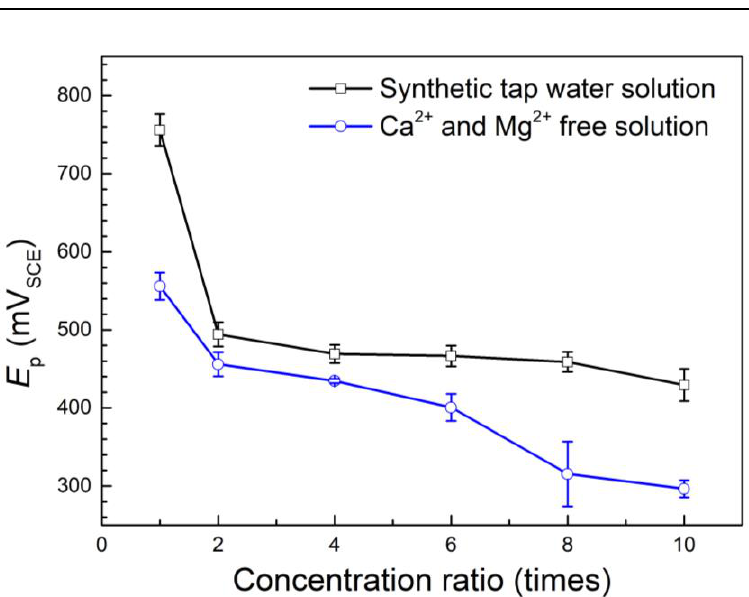
Figure 12. Pitting potentials of specimens in the two solutions with different concentration ratios.